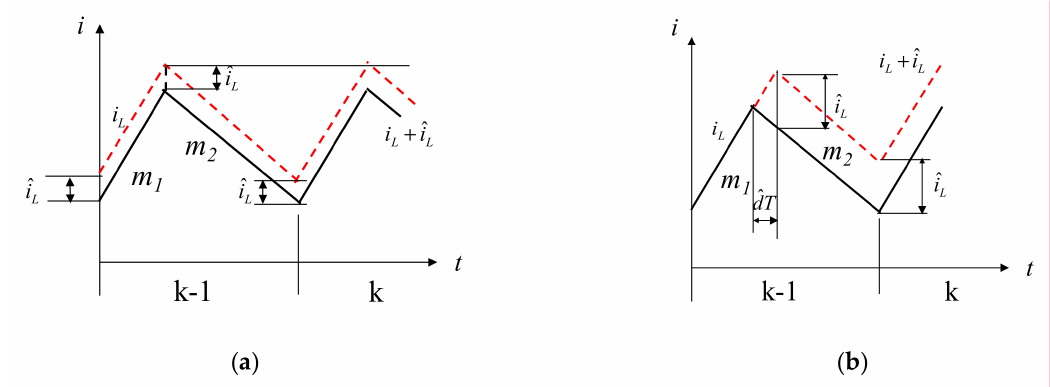
Figure 5. Simplified digital modeling of the Boost converter. ( a ) Natural response and ( b ) forced